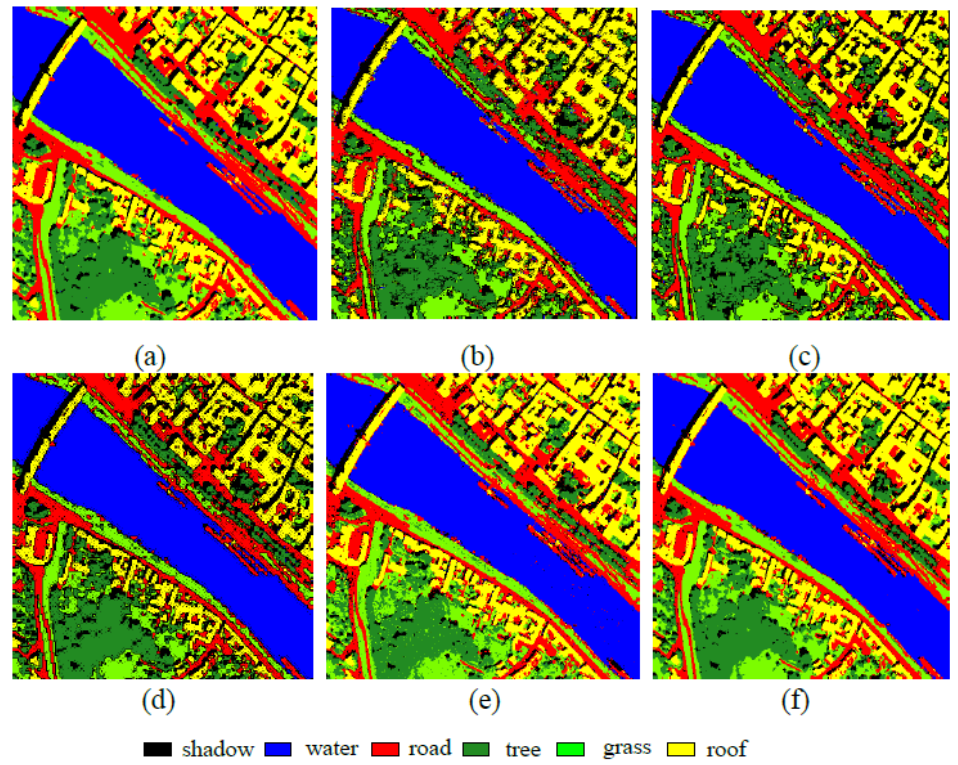
Figure 14. SRTM in experiment 2 ( 2 S ). ( a ) Reference image; ( b ) BI result; ( c ) BIC result; ( d ) MAP result; ( e ) MTC result; ( f ) PTC result. Table 3. Accuracy (%) of five methods in experiment 2 (